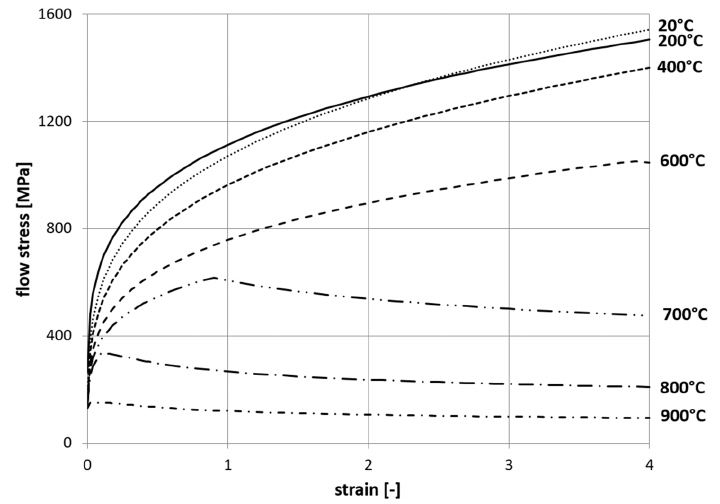
Figure 10. Flow stress curves as a function of temperature for ˙ ε = 0.0001 s − 1